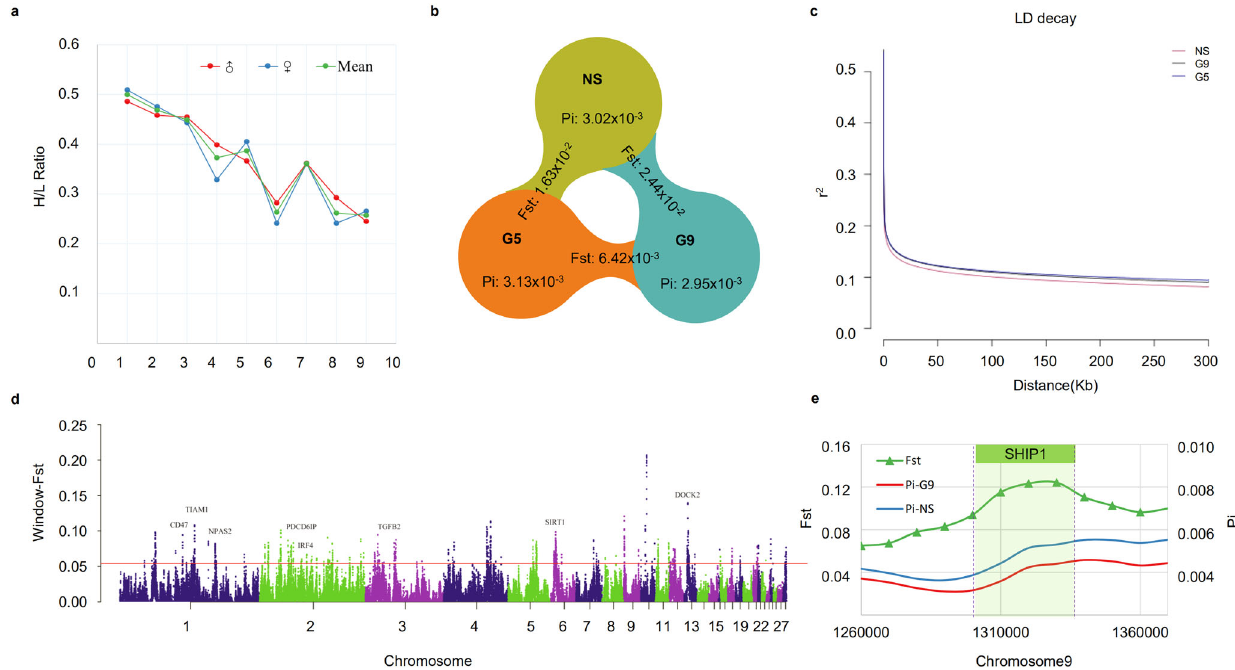
Fig. 2 Selection for H/L causes genetic differentiation. a Phenotype progress over the course of H/L breeding. b Summary of nucleotide diversity (Pi) and population divergence (Fst) across selected and non-selected groups. Values in each circle represent nucleotide diversity for the group, and values between pairs indicate population divergence (Fst). NS, non-selection line; G5, 5th generation; G9, 9th generation. c Decay of linkage disequilibrium (LD) in the three groups, measured by r2. d Pairwise fi xation index (Fst) in 40-kb sliding windows across autosomes between G9 and NS. The dashed horizontal line indicates the Fst cutoff (top 1%). Genes located in divergence regions annotated by Ensembl BioMart are indicated by their gene names. e CDRs are enriched for sites on chromosome 9, the gene set for the FcR and ITIM pathways.